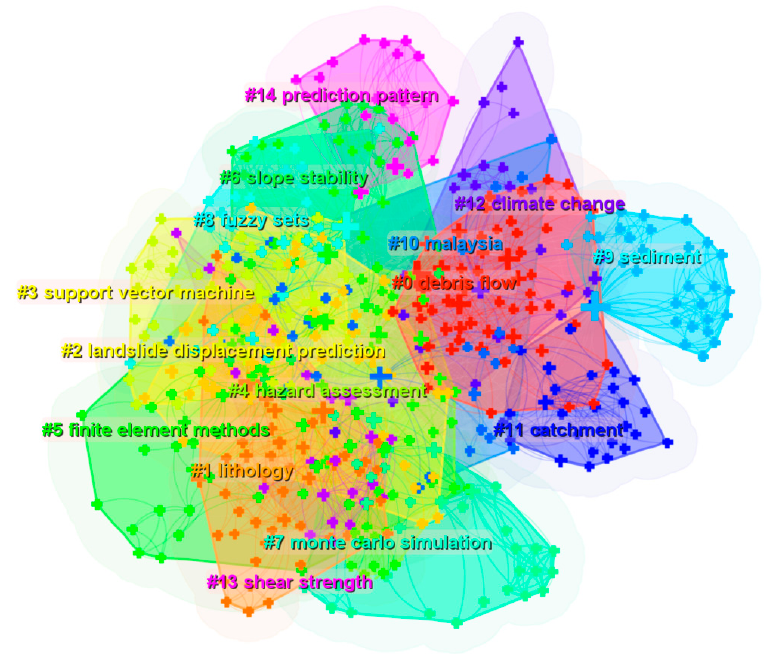
Figure 10. Cluster graph of